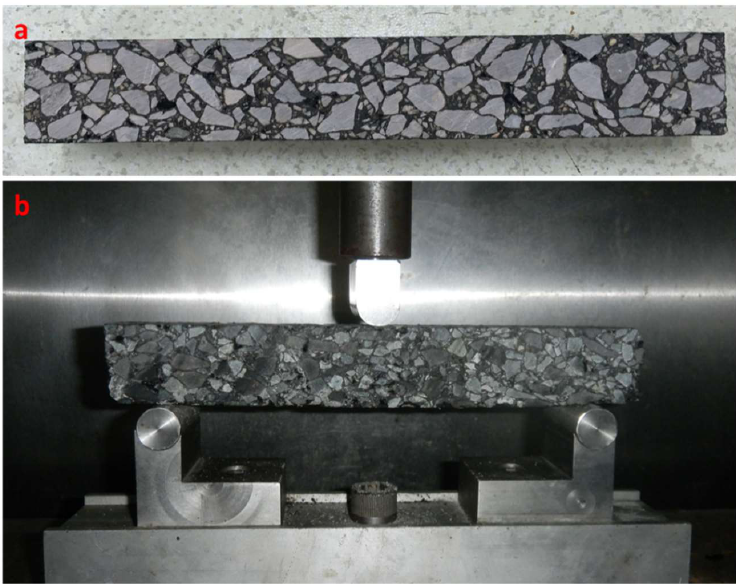
Figure 2. Specimen and setup used for three-point bending test: ( a ) prismatic beam; ( b ) test setup.